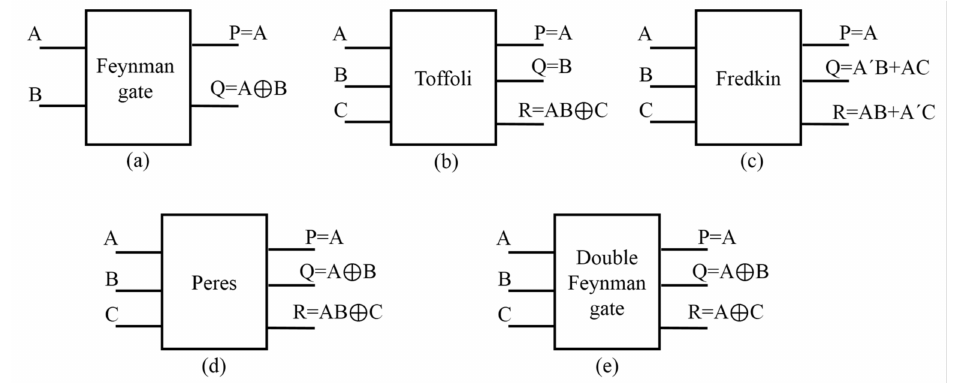
Figure 1. The block diagrams of the reversible gates: ( a ) the Feynman [26], ( b ) the Toffoli [27], ( c ) the Fredkin [28], ( d ) the Peres [29], and ( e ) the double Feynman gate [30]. Figure 1a indicates the Feynman gate’s block diagram, and Figure 2 indicates its implementation based on QCA. Figure 3a indicates the block diagram of the double Feynman gate, and Figure 3b indicates its QCA. The output vector is O (R, P, and Q), and the input vector is I (B, C, A). R = A ⊕ C, Q = A ⊕ B, P = A specify the output. The